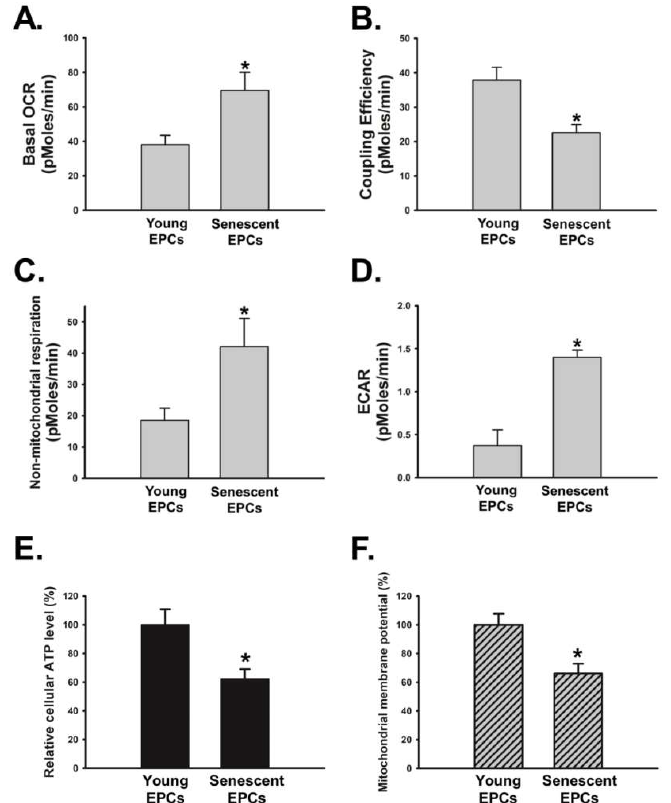
Figure 6. Effect of senescence on bioenergetic homeostasis in OBCM-treated EPCs. Young and senescent EPCs were incubated with OBCM of MC3T3-E1 cells for 24 h. ( A – D ) Oxygen consumption rate (OCR) and extracellular acidification rate (ECAR) were determined by the Seahorse XF24 analyzer. Meanwhile, coupling efficiency and non-mitochondria respiration were assessed by bioenergetic analysis in cells exposed to mitochondrial component inhibitors using XF24 analyzer ( N = 5); ( E , F ) The ATP synthesis and mitochondrial membrane potential of EPCs were examined by ATP detection assay and Mito-ID ® assay kit, respectively ( N = 5). Data are expressed as mean ± S.E.M. of five independent experiments. * p < 0.05 compared with the group of young